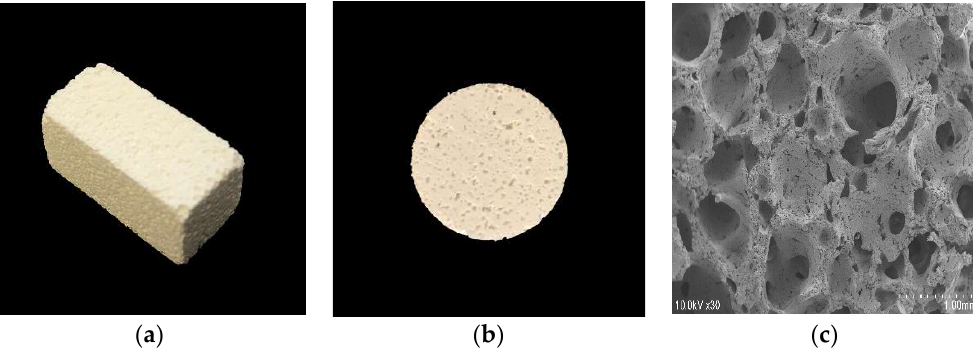
Figure 1. The three-dimensional porous uncalcined and unsintered hydroxyapatite and poly-D/L-lactide (3D-HA/PDLLA) biomaterial used in this research. ( a ) The size of the 3D-HA/PDLLA cellular cubic composite was 23 × 10 × 10 mm. ( b ) The size of the 3D-HA/PDLLA sheet was Φ20 × 2 mm. ( c ) Scanning electron microscope (SEM) image of 3D-HA/PDLLA scaffold. Scale bar: 1 mm.